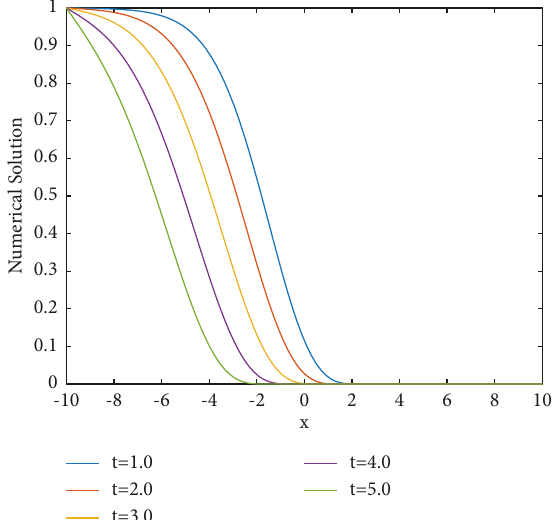
Figure 7: Wave profile of problem 2 at different time. Figure 8: Wave profile of problem 2 at different